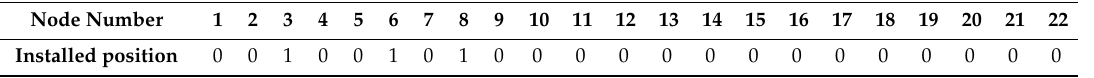
Figure 2. An example of auto-tap-changer pole transformer (ATCTr) installation placement cording. Table 2. Binary coding use for ATCTrs placement in nodes.